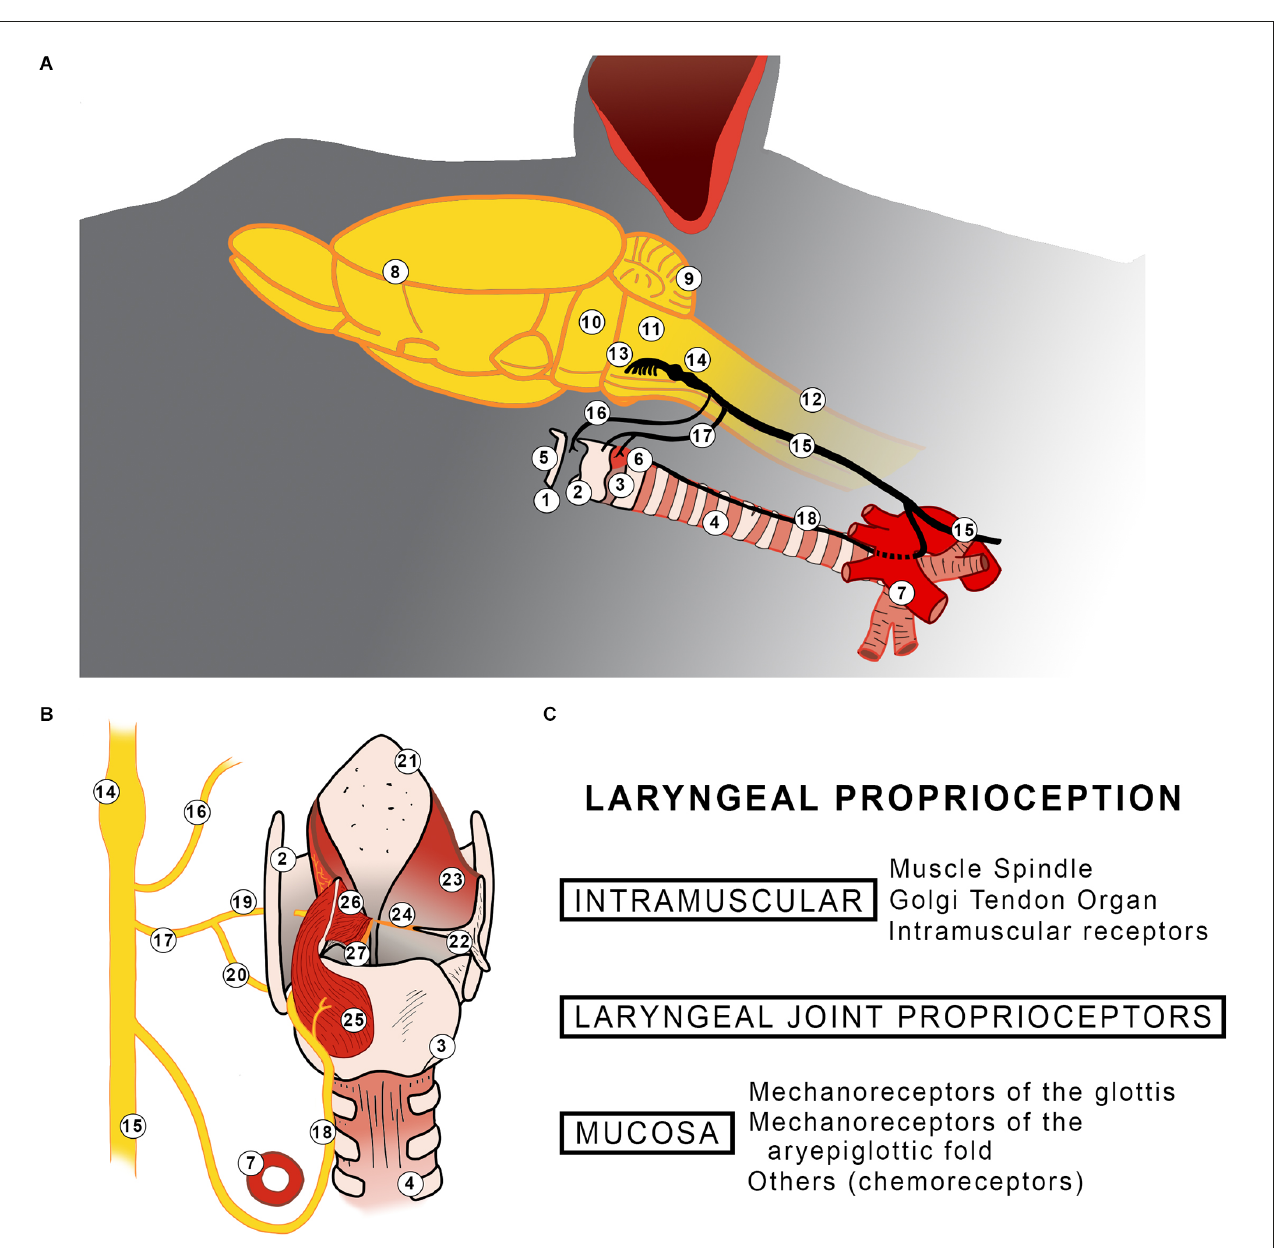
FIGURE1 (A) Diagram summarizing the location of the larynx and its innervation in rodents (A) . A representation of the posterior view of the rat larynx (B) . The left side shows innervation, posterior cricoarytenoid, lateral thyroarytenoid, and medial thyroarytenoid muscles. The superior cricoarytenoid and the cricothyroid muscles are not shown. The right side shows aryepiglottic fold having the arytenoid cartilage is displaced and all intrinsic laryngeal muscles excised. Findings of laryngeal proprioceptors reported in the literature (C) . 1: Larynx; 2: Thyroid cartilage; 3: Cricoid cartilage; 4: Trachea; 5: Hyoid bone; 6: Cricothyroid muscle; 7: Aorta arch; 8: Telencephalon; 9: Cerebellum; 10: Pons; 11: Medulla oblongata; 12: Spinal Cord; 13: Origin of vagus nerve; 14: Nodose and Jugular ganglion; 15: Vagus nerve; 16: Pharyngeal branch; 17: Superior laryngeal nerve; 18: Recurrent laryngeal nerve; 19: Internal branch of superior laryngeal nerve; 20: External branch of superior laryngeal nerve; 21: Epiglottis; 22: Arytenoid cartilage; 23: Aryepiglottic fold; 24: Vocal fold; 25: Posterior cricoarytenoid muscle; 26: Lateral thyroarytenoid muscle; 27: Medial thyroarytenoid muscle.